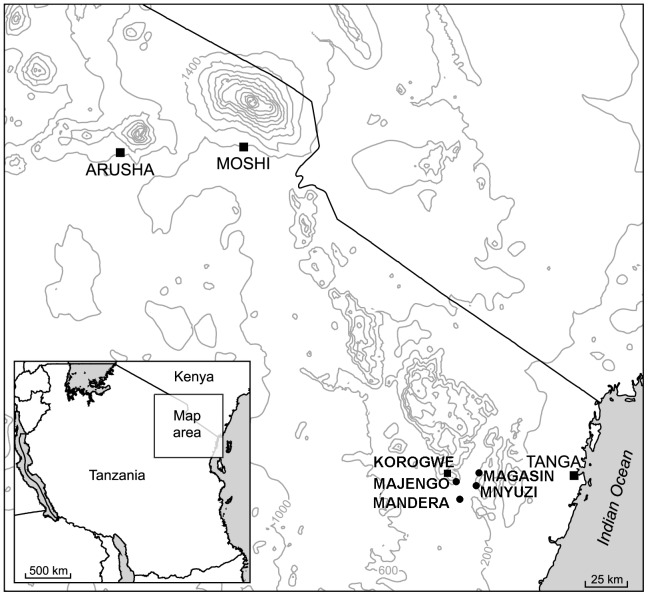
Map of Tanzania showing the north-eastern provinces, and the location of Korogwe district.Sampling in Korogwe district was conducted in 5 areas, which are marked on the map: Korogwe, Majengo, Magasin, Mnyuzi, and Mandera. Within these areas, our study population were resident in 15 subvillages. Korogwe consisted of the following subvillages: Kwasemangube (KS), Lwengera (LW) Msambazi (MS) and Masuguru (MU). Majengo consisted of the following subvillages: Kilole (KI), Majengo (MJ) and Manundu (MA). Magasin consisted of the following subvillages: Kwagunda (KW) and Maguga (MG). Mnyuzi consisted of the following subvillages: Gereza (GE), Lusanga (LU), Mkwakwani (MK), Mnyuzi (MY) and Shambakapori (SH). Mandera (MD) was an isolated subvillage.